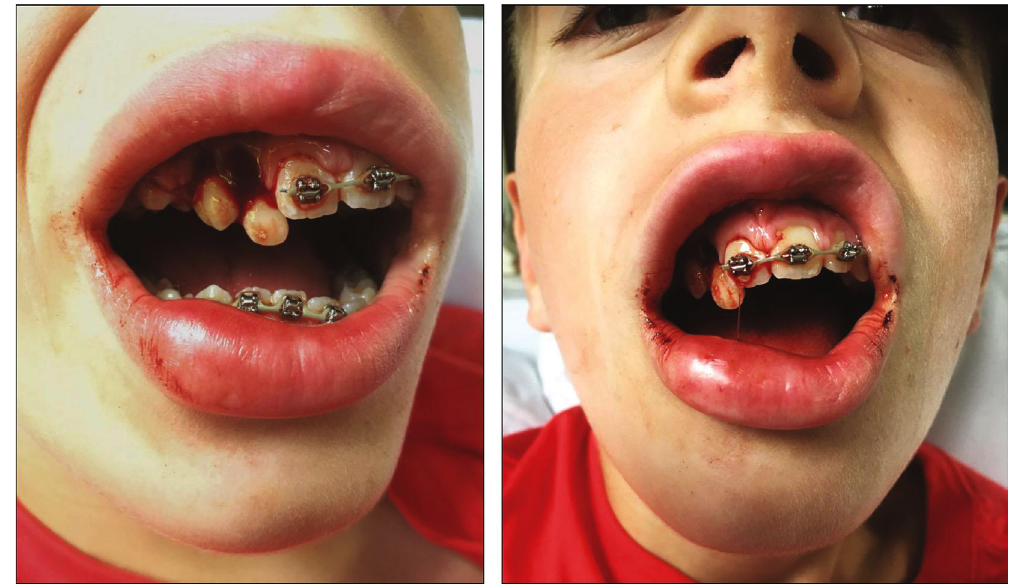
Figure 5: Intraoral pictures taken by the patient shortly after emergency dental